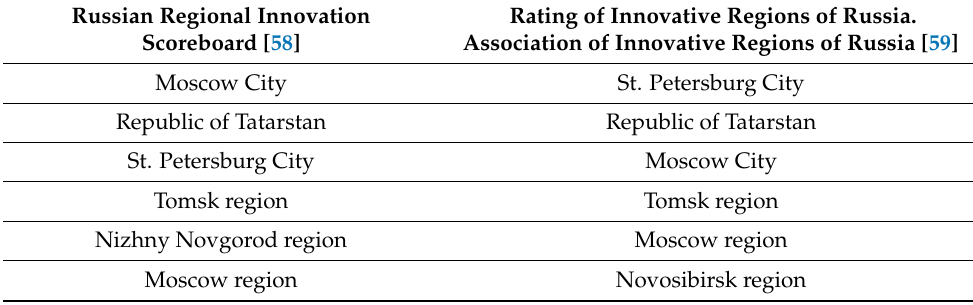
Table 1. Top-rated innovative regions of